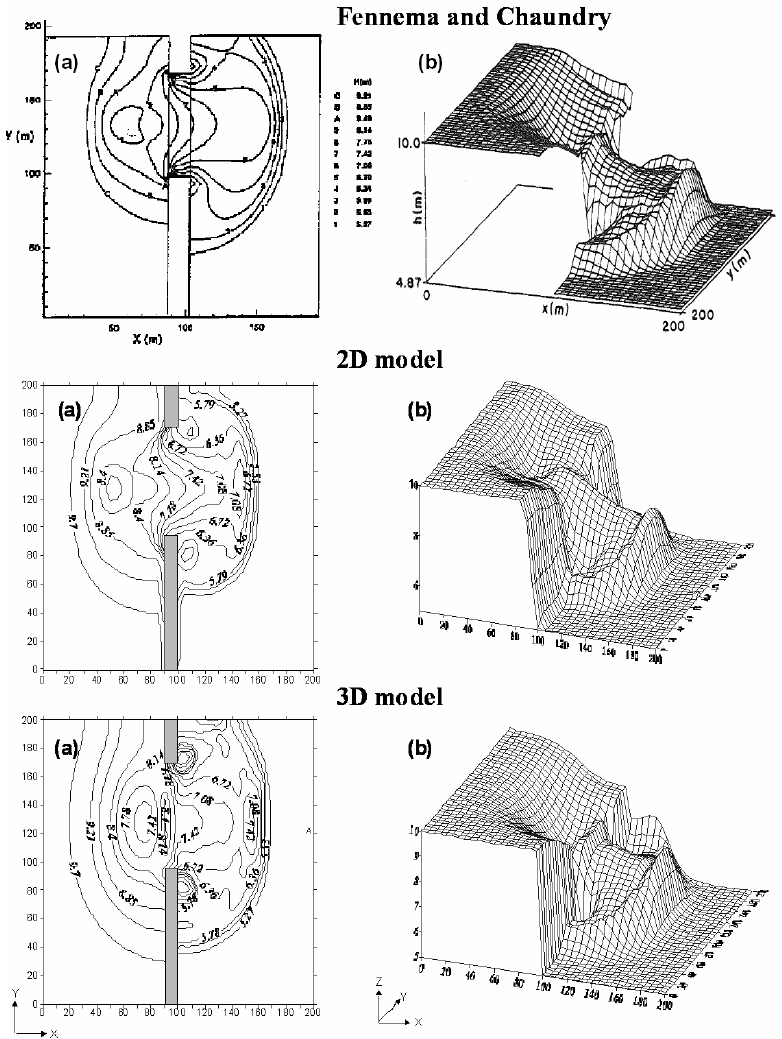
Fig. 3. Comparison between Fennema and Chaundry (1990), shallow water, full Navier Stokes simulations’ results: (a) Contour levels at 5.2m, 5.7m, 6.2m, 6.7m, 7.2m, 7.8m, 8.2m, 8.7m, 9.2m (b) Water surface wireframe (three-dimensional view) after 7.2s from